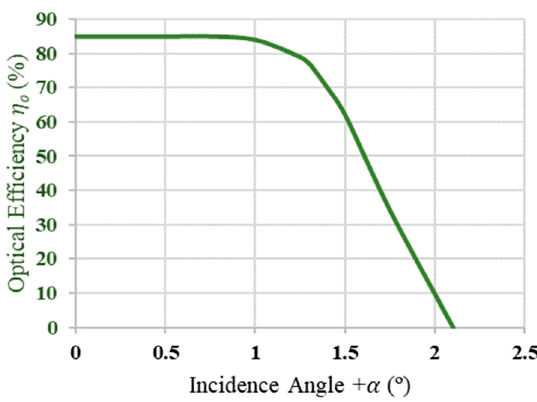
Figure 9. The concentrator’s optical efficiency (POE + SOE) at different incidence angles for Case 2.